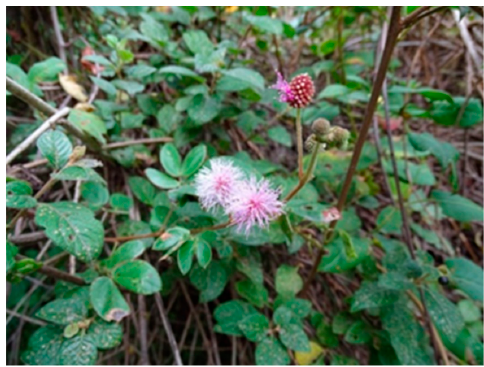
Figure 1. Mimosa albida plant.